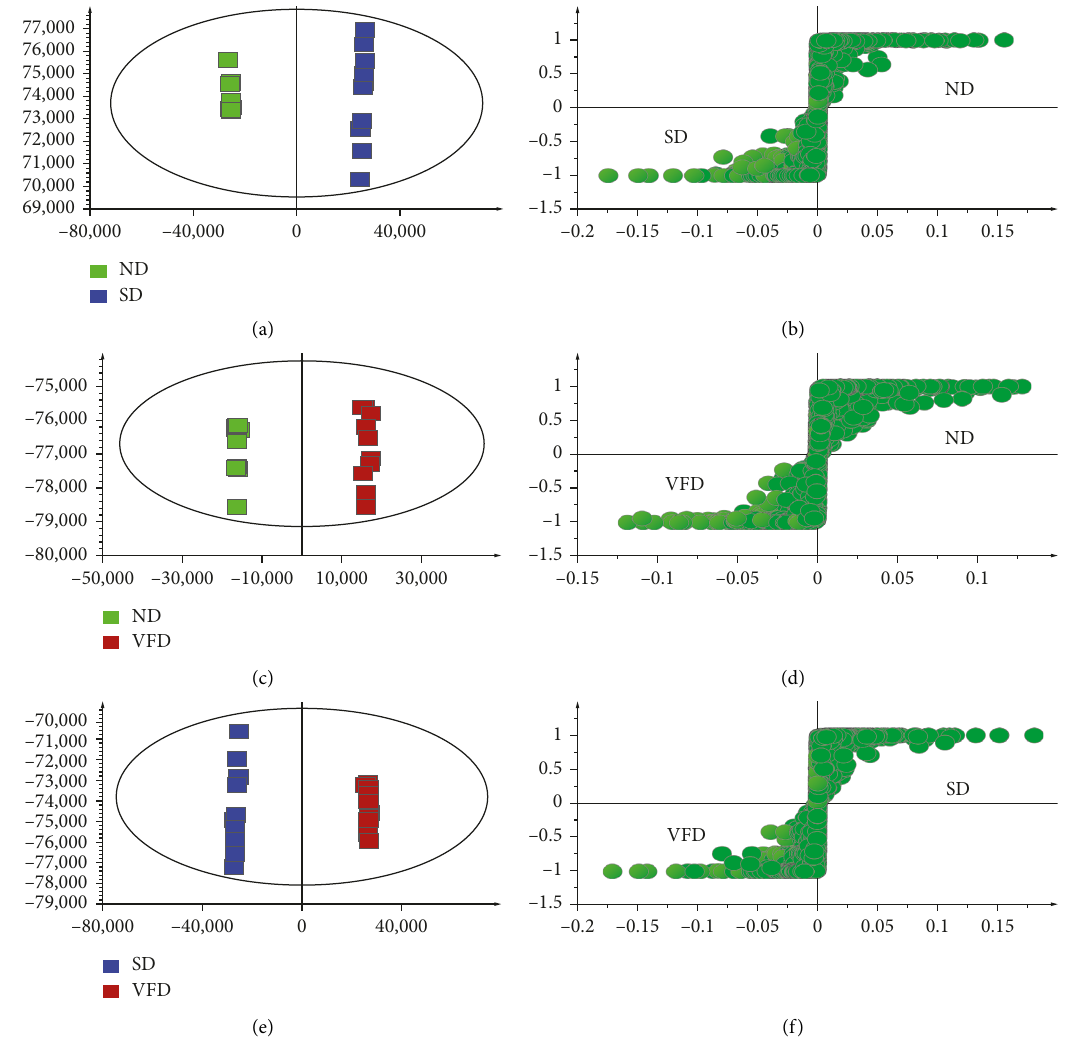
Figure 4: The OPLS-DA/S-plot of ND vs. SD, ND vs. VFD, and SD vs.